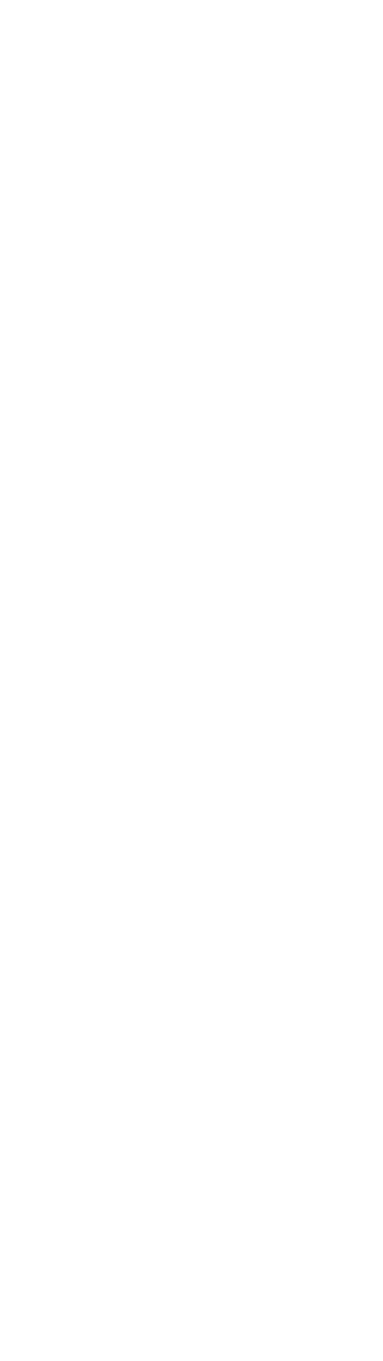
FIGURE 6 Scatter plot of the relationship between the positive sites of P. echinogaster eDNA and environmental variables. The x-axis represents environmental variables (A) and sampling depth (B) . The y-axis represents logarithm-transformed eDNA concentrations. Black spots denote sampling